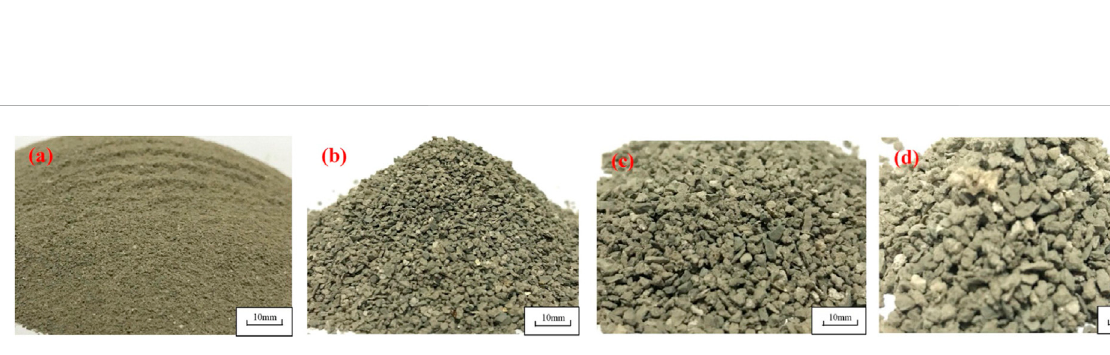
FIGURE 4 Physical imagesof insolubleparticles in salt cavern gas storage with different diameters. (A) ( < 0.5 mm); (B) (0.5 – 1.0 mm); (C) (1.0 – 2.0 mm); (D) (2.0 – 3.0